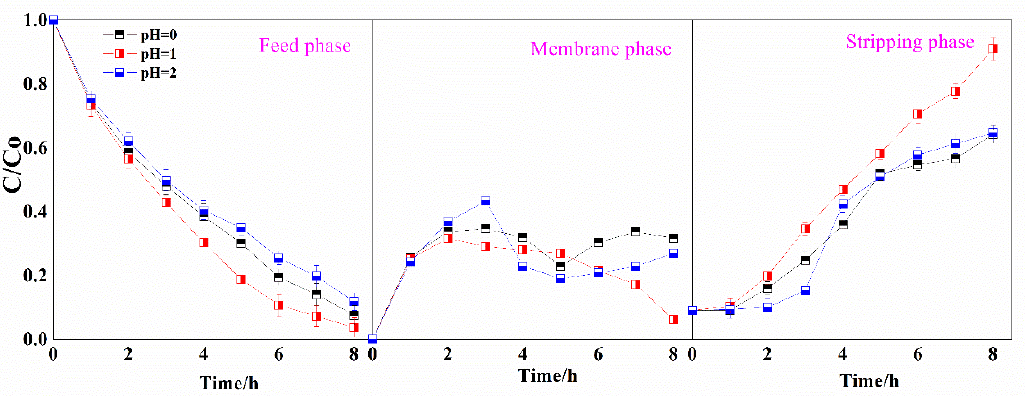
Figure 8. Effect of stripping pH on the transport of Ga(III) by SLMs ([Ga(III)]feed = 400 mg/L, Carrier = 0.5 M R 4 NCy).